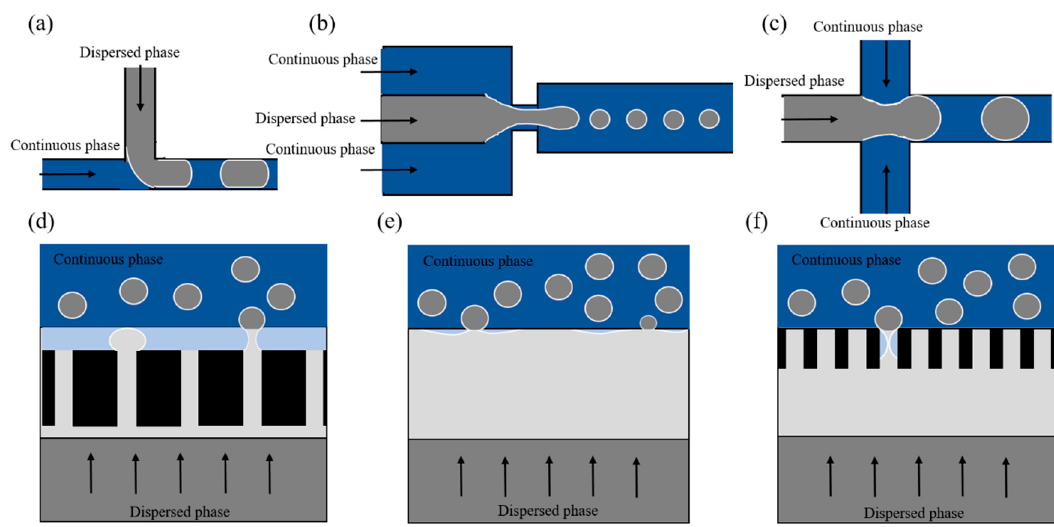
Figure 2. Schematiclayoutofmicrofluidicdevices: ( a )T-junction,( b )flow-focusing,and( c )co-flowingdevice; ( d ) terrace-based microchannel (MC); ( e ) Edge-based Droplet GEneration (EDGE), and ( f ) partitioned-EDGE droplet formation unit. Please note that in the top three devices channels have the same depth, while in the bottom three, a height di ff erence is needed to allow spontaneous droplet formation to take place. Deep channels (of all the designs) and shallow areas (in the bottom three designs) are indicated as dark grey and light grey, respectively. The continuous phase (water phase) has a blue color, and shows as dark blue when flowing in the deep channel, and as light blue when in the shallow areas. The gas has no color in this figure. The white outline indicates the gas—water interface. These schematics are not drawn to scale.